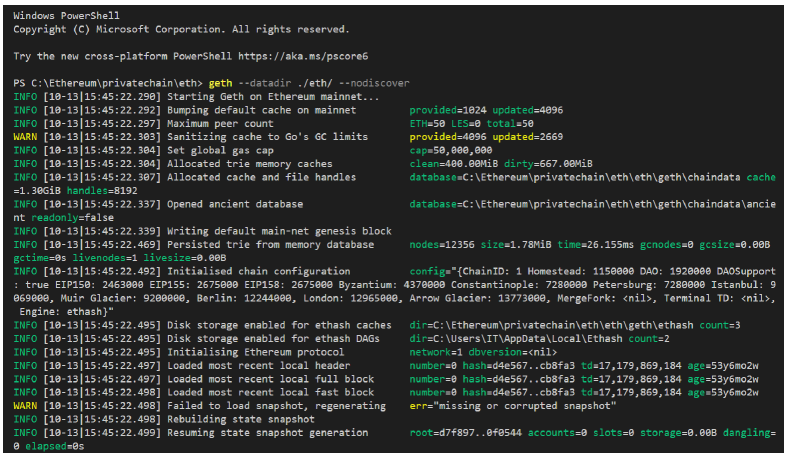
Figure 10. Private Ethereum network.